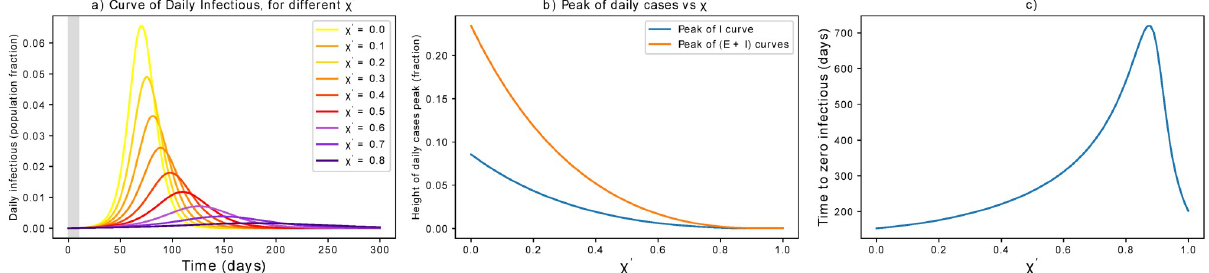
Fig 5. Effect of latent carriers quarantining. (a) Effects of active latent carriers quarantining on the epidemic curve. The grey area indicates when measures are not yet in place. (b) The peak is progressively flattened until a disease-free equilibrium is reached for sufficiently large χ 0 . (c) Unless χ 0 is large enough, stronger measures of this kind might delay the mitigation of the epidemic. Note that the critical χ 0 can be lowered for higher θ , e.g. if preventive quarantine does not wait for a positive test.